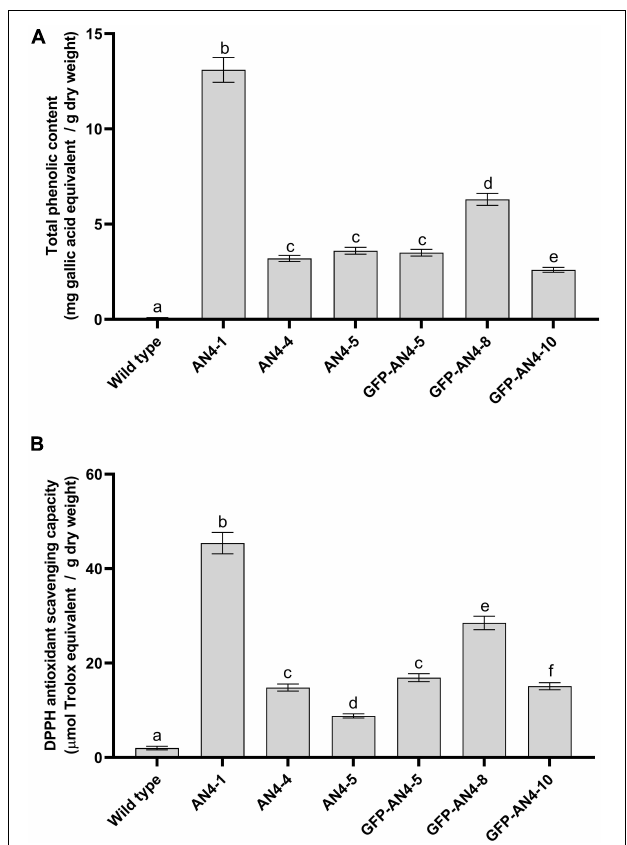
FIGURE 7 | Total phenolic content in MicroTom transgenic HRCs reported in mg of gallic acid equivalents/g of dry weight (A) . Analysis of antioxidant activity (DPPH) in MicroTom transgenic HRCs reported as µ g Trolox equivalents/g dry weight (DW) (B) . Each analysis consisted of triplicate measurements of each sample and data were averaged over the three measurements. A univariate statistical analysis based on Student’s t -test and one way-ANOVA ( P ≤ 0.05) was carried out.